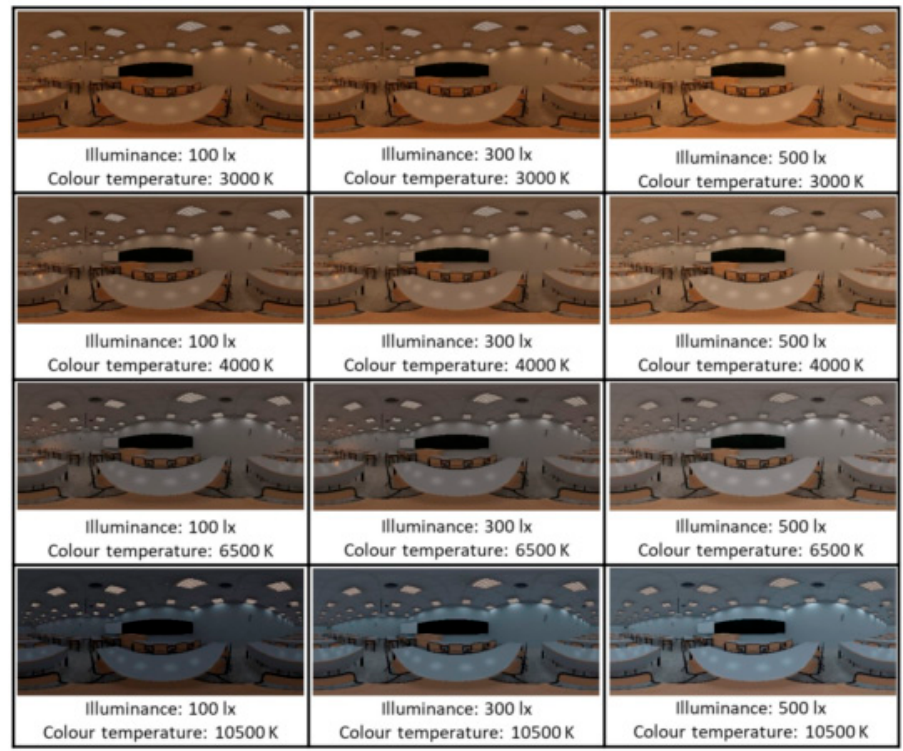
Figure 4. Virtual classrooms modified in lighting.